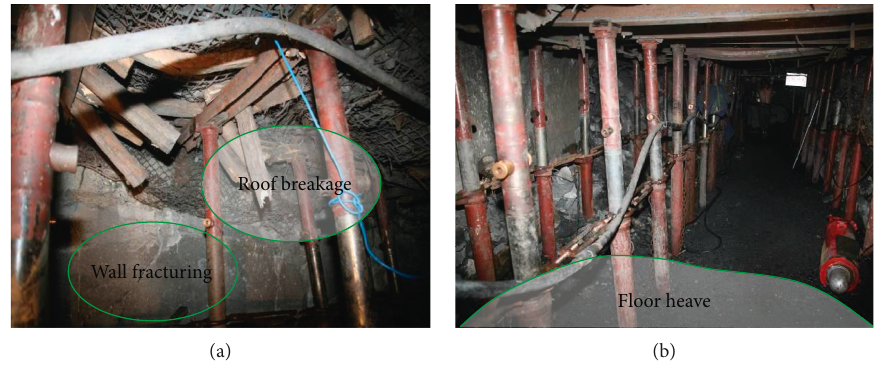
Figure 5: Pictures of failure characteristics: (a) roof breakage and wall fracturing; (b) floor